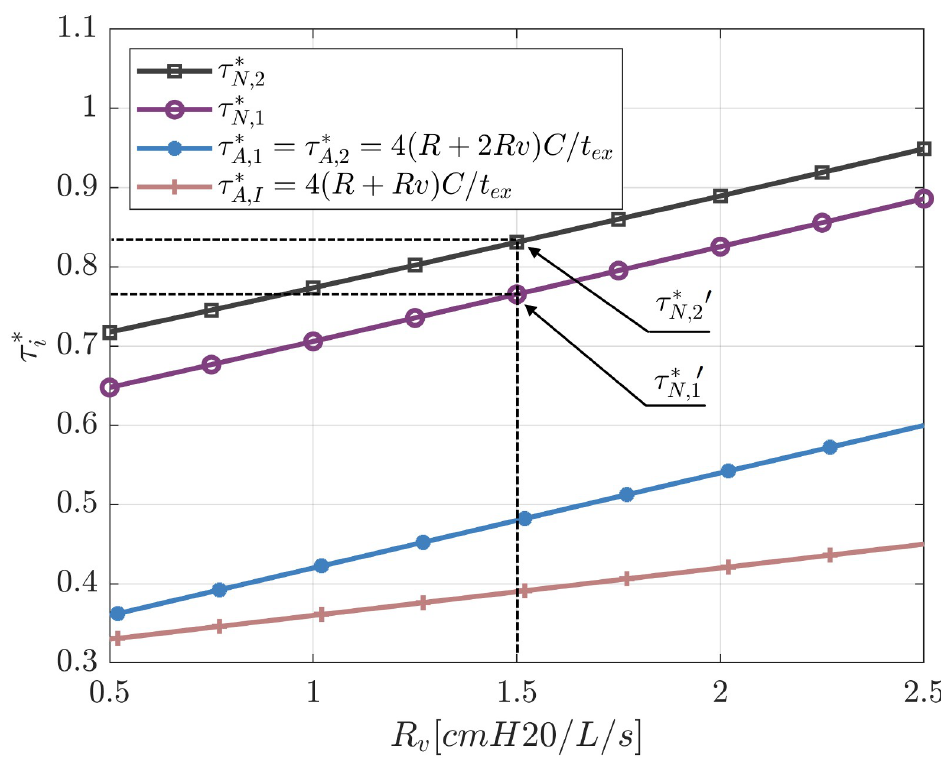
Fig 8. Influence of exhalatory valve resistance on characteristic times for symmetric conditions ( PEEP 1 = PEEP 2 = 5 cm H 2 O, DP 1 = DP 2 = 15 cm H 2 O, R 1 = R 2 = 5 cm H 2 O (L/s) − 1 , C 1 = C 2 = 35 ml (cm H 2 O) − 1 and K cm H 2 O (L/min) − 2